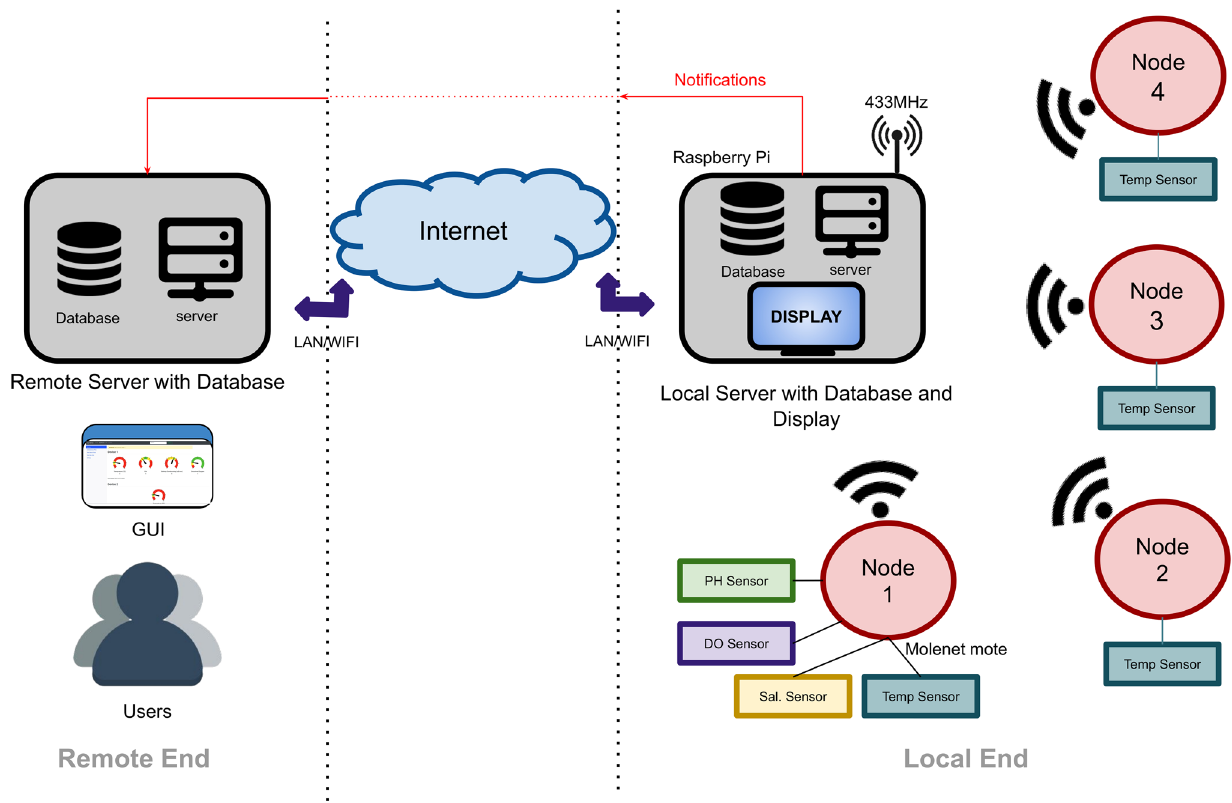
Fig. 1 Architecture of H